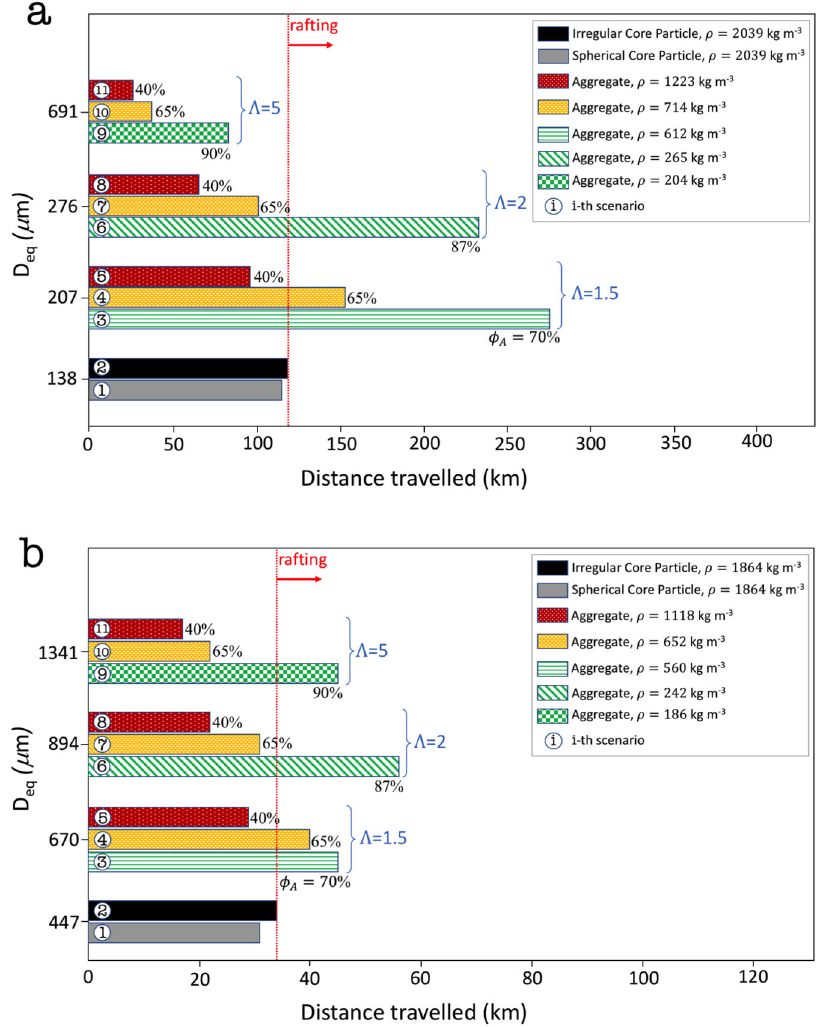
Fig. 5 Premature or delayed sedimentation during the 2010 Eyjafjallajökull eruption. Sedimentation distances traveled by core particles of 138 μ m ( a ) and 447 μ m ( b ) when they are considered as single objects, either spherical or with their observed shape 23 , or when they act as a core for aggregates with different size ratios Λ and porosities ϕ A (note different x-axis scales); particles of 138 μ m and 447 μ m correspond to the median of the equivalent diameters d = ( L I S ) 1/3 of all the objects belonging respectively to the bins phi = 3 and phi = 2. Particle shape re fl ects observations for the Eyjafjallajökull ash 23 . The eq median value is used as supposed to the arithmetic mean to guarantee that both the diameters and the shapes used in the simulations were really observed during the eruption. Reported travel distances represent the great circle distance from the vent. The maximum travel distance of a particle/aggregate is de fi ned as the point at which 95% of its erupted mass had been